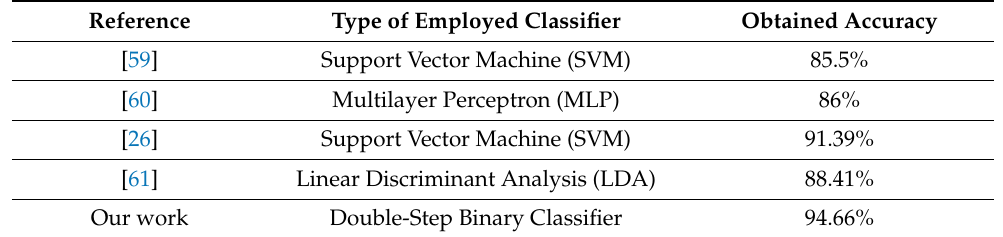
Table 7. Comparison between the proposed algorithm and three available algorithms.